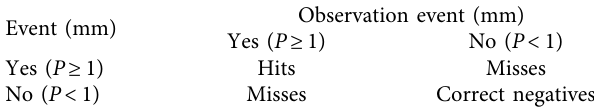
Table 3: Contingency table for categorical evaluation indices. Observation event Event (mm)